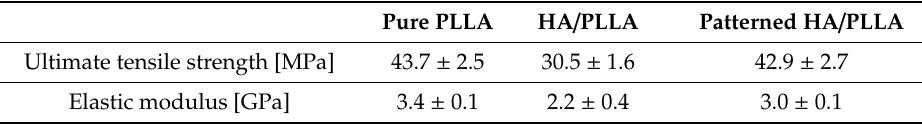
Figure 3. ( A ) Wetting angle and ( B ) tensile properties of pure PLLA, HA/PLLA, and patterned HA/PLLA (Statistically significant vs. pure PLLA and patterned HA/PLLA: * p < 0.05, ** p < 0.01). Table 1. Tensile properties of PLLA and its composites.